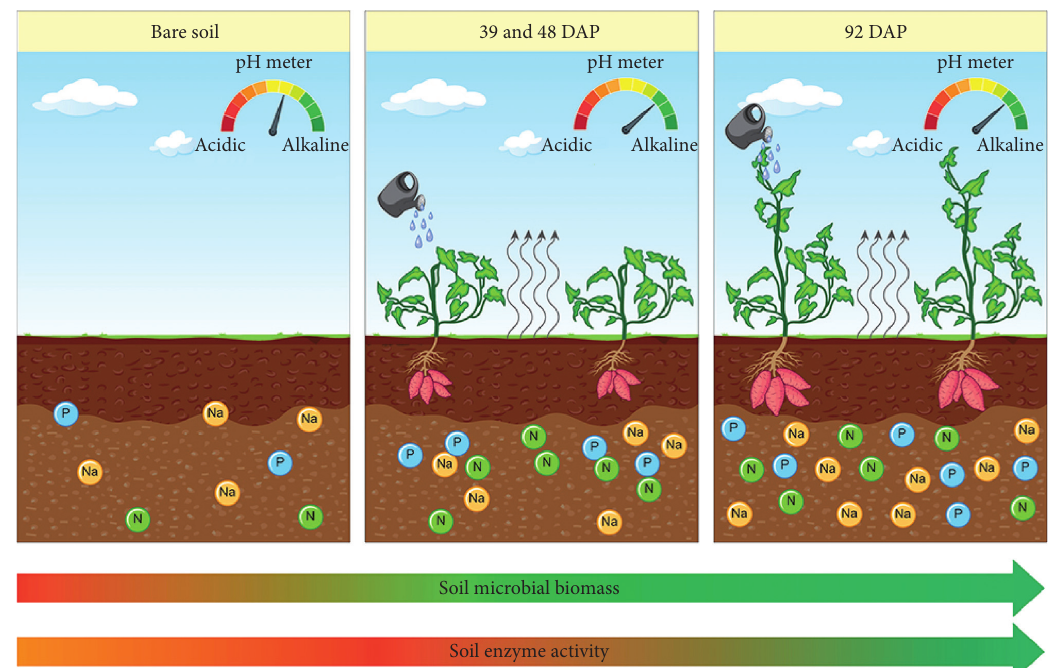
Figure 4: Chemical and biological changes in soils upon cultivation with sweet potatoes and drip irrigation during the summer in semiarid South Texas. DAP � days after